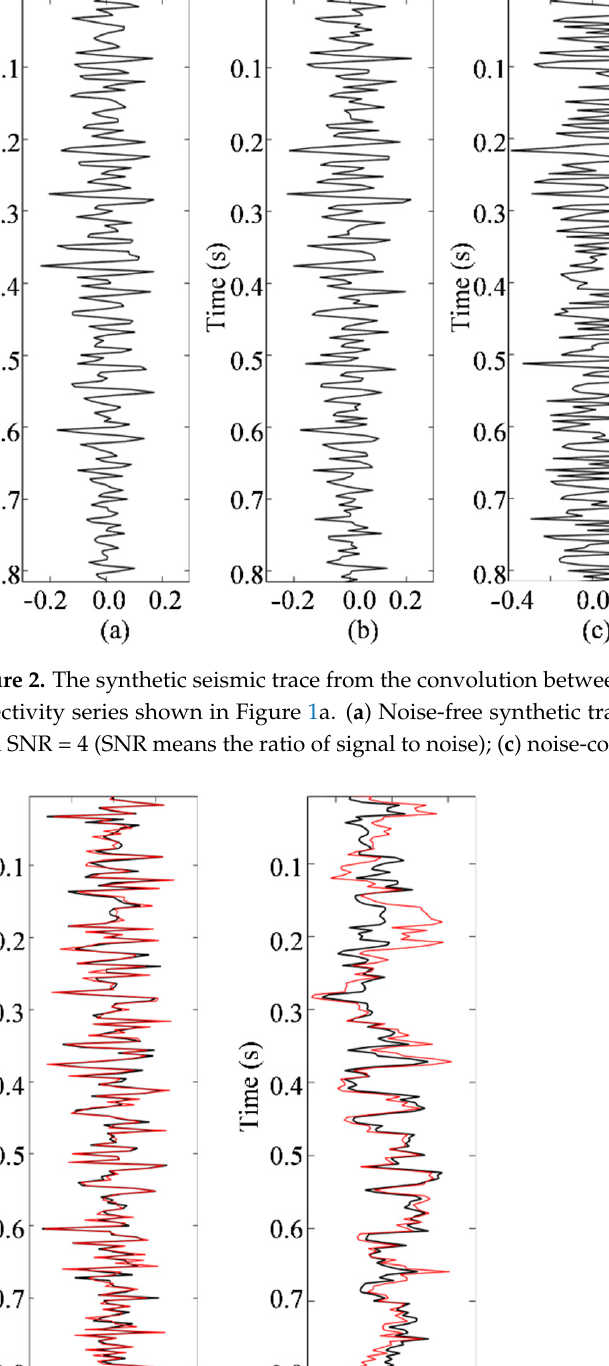
Figure 4. The inverted reflectivity series and impedances from L1R1 performed on the noise-free synthetic trace. ( a ) Reflectivity series; ( b ) impedance.